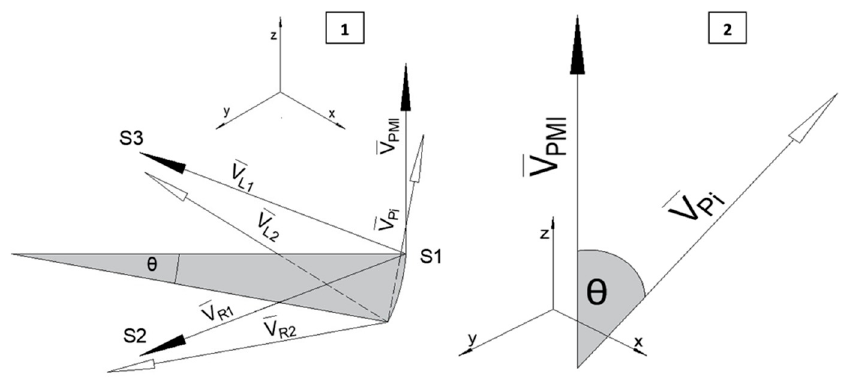
Figure 5. ( 1 ) Vectors V R and V L (1 in MIP, 2 in position of interest) constructed with the premolar sensors and the interincisal sensor, vector V P will be perpendicular to them. The black arrows indicate when the system is in MIP, the whit arrows are with the system in the position of interest. ( 2 ) Diagram of the angle between the perpendicular vectors in MIP and the position of interest. The angle between them is equal to the inclination of the mandible.